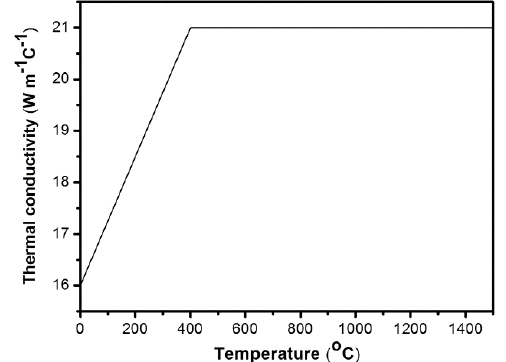
Figure 3. Temperature-dependent thermal conductivity for base and weld metal.